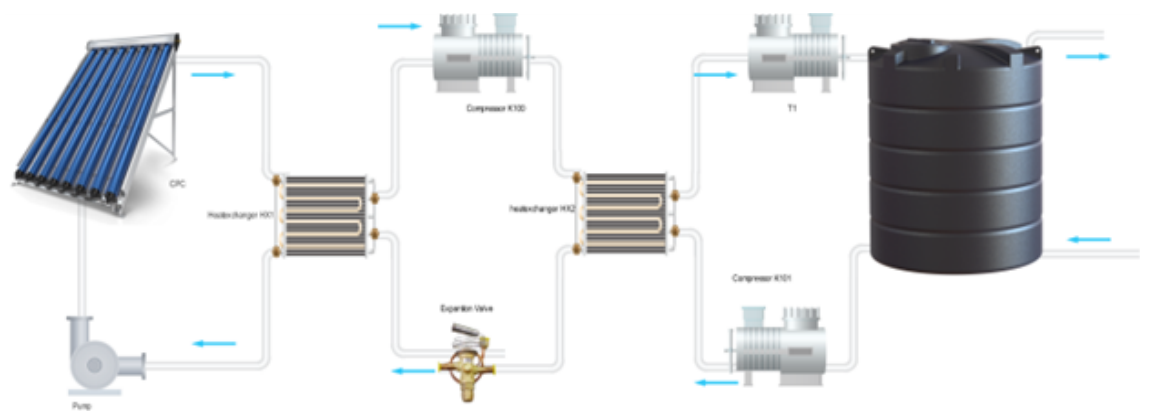
Figure 1. Process of the hot water production